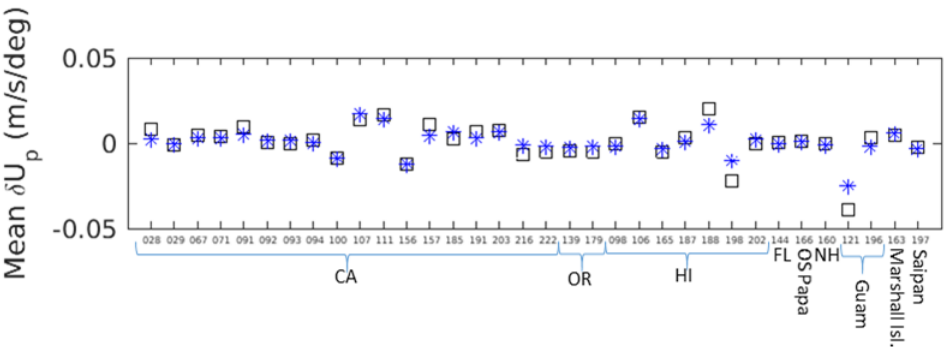
Figure 11. Average of current shear acting along the line of the peak wave direction, at all analyzed buoy sites. X-axis labels indicate buoy number and location. Rogue event data are depicted by black squares, and non-rogue data are shown as blue asterisks.